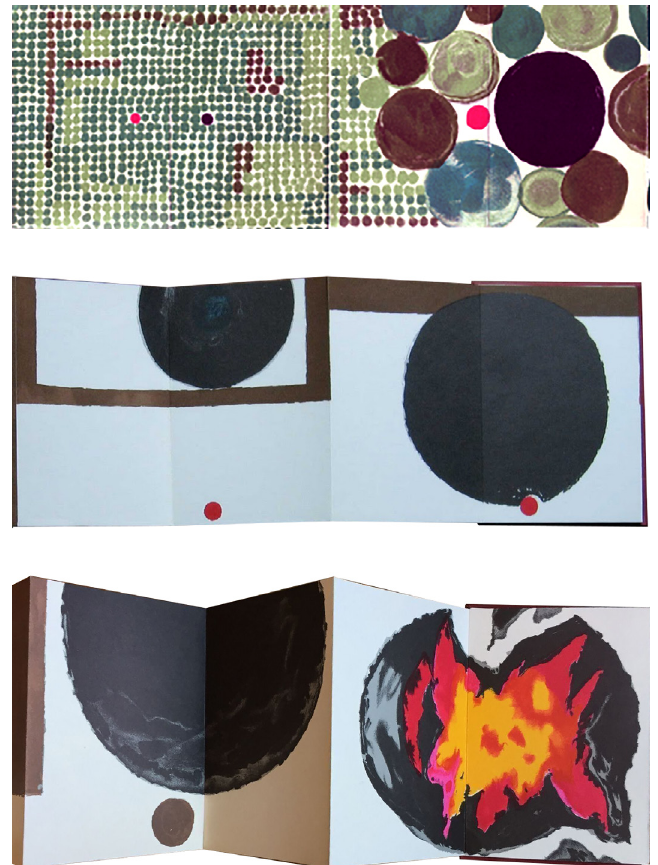
Fig. 4 Warja Lavater. Little Red Riding Hood walks in the forest ; She meets the wolf . Warja Lavater (1963). Le Petit Chaperon Rouge . Paris: Maeght.